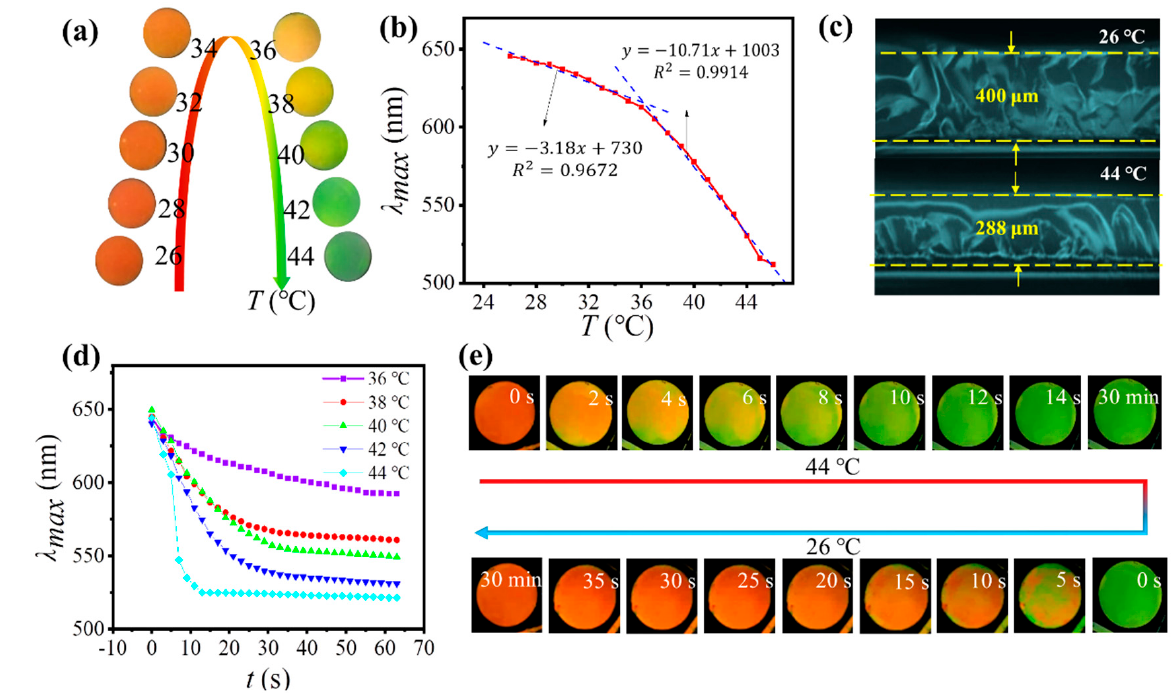
Figure 2. ( a ) Digital photos of the TRPCF-PNC under different temperatures in the range of 26 °C~44 °C. ( b ) The maximum peak wavelength ( λ max ) as a function of temperature ( c ) Cross-sectional optical microscope images of the TRPCF-PNC under 26 °C and 44 °C, respectively, showing large deformability along its thickness direction. ( d ) λ max as a function of t when the same film is transferred from 26 °C to different water baths with various temperatures. ( e ) A series of digital photos recorded a recycled color change of TRPCF-PNC when the film was first transferred from a water bath of 26 °C to 44 °C and then back to 26 °C.